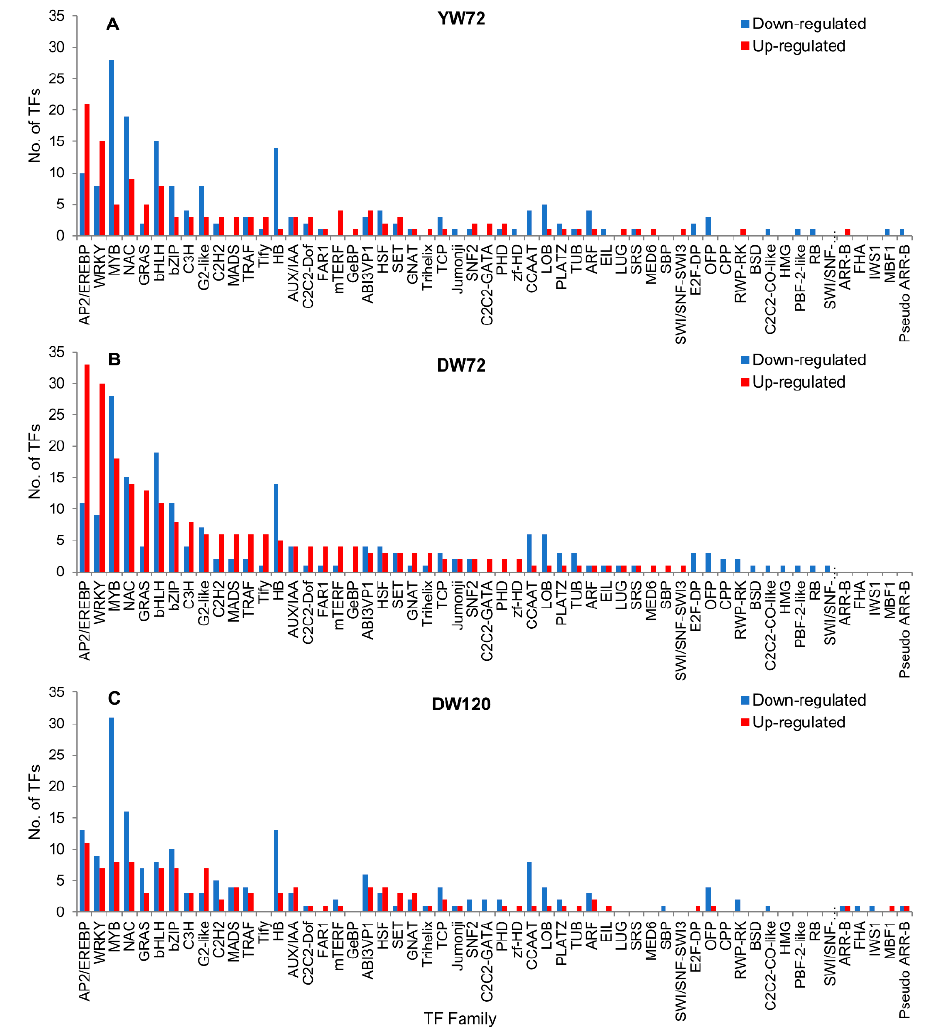
Figure 5. Transcription factors identified in differentially expressed genes in Yerong roots at 72 h ( A ) of waterlogging stress, and Deder2 roots at 72 ( B ) and 120 h ( C ). YW72, Yerong 72 h of waterlogging; DW72, Deder2 72 h waterlogging; DW120, Deder2 120 h waterlogging.